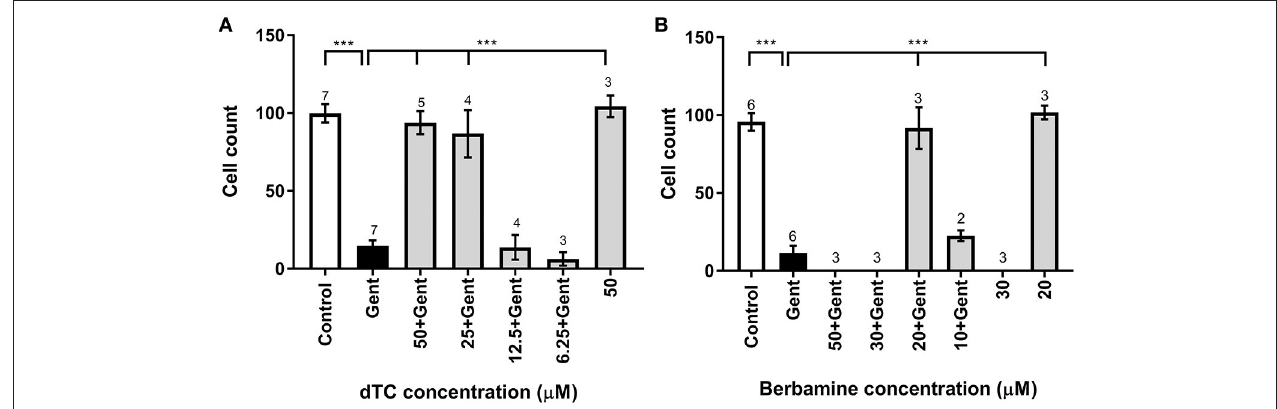
FIGURE 4 | Quantification of survival of OHCs exposed to gentamicin and otoprotective compounds. (A,B) Bar charts showing average numbers of OHCs remaining after 48 h in medium alone (control), in medium containing 5 µ M gentamicin, in 5 µ M gentamicin plus different concentrations of compounds, and in medium containing the compound alone. Number of OHCs were counted in a 220 µ m wide field. Significant protection occurs at dTC concentrations of 25 µ M and above (A) and for 20 µ M berbamine (B) . While 50 µ M dTC alone does not cause OHC damage, OHCs are obliterated at ≥ 30 µ M berbamine, with or without gentamicin. Numbers above the bars indicate experimental replicates. *** p < 0.001.